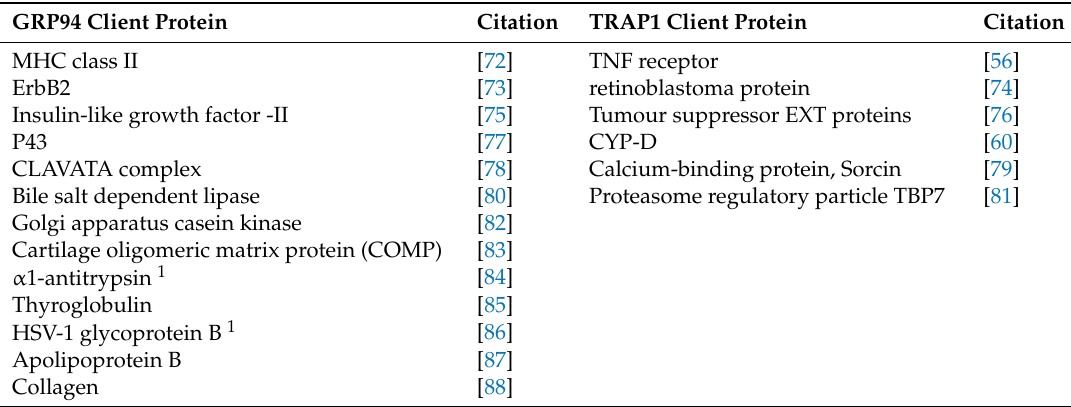
Table 3. Protein clients of GERP94 and